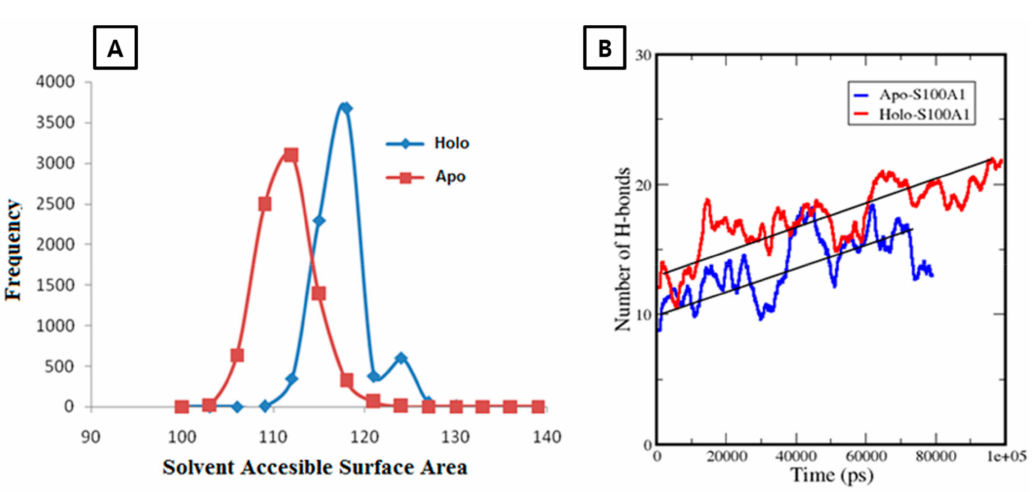
Figure 4. A represents the solvent accessible surface area (SASA) over the frequency distribution of apo-S100A1 and holo-S100A1. B shows H-bond changes in an apo (red) and holo (blue) state during simulation of 80 ns and 100 ns, respectively. Calculations take place between subunits A and B of each system separately at a cut-o ff of 0.35 nm. Straight black lines are drawn to depict the average of H-bonds of each system. A rise of ~10 H-bonds in holo-S100A1 revealed firmness of the